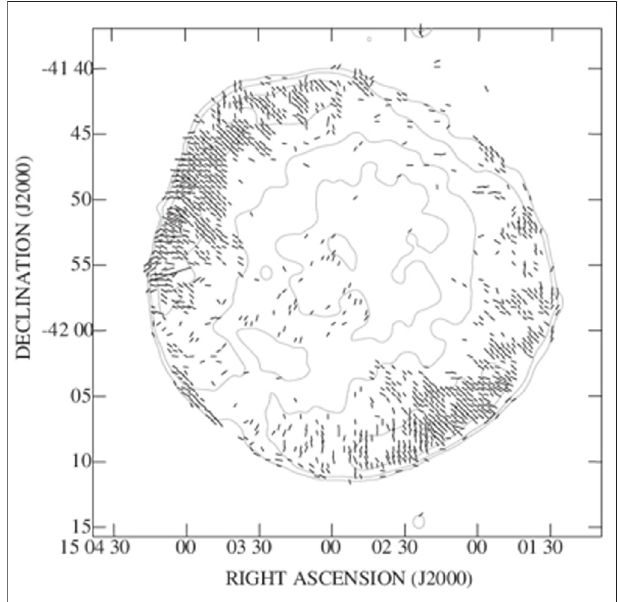
FIGURE2| Magnetic- fi eldorientationonSNRSN1006derivedfromthe radio polarimetry at 10 arcsec resolution (1.4 GHz). The polarization angle is corrected for Faraday rotation (assuming uniform rotation measure as 12 rad m − 2 ). Total intensity contours at 10, 20, and 50 mJy beam − 1 are superposed. For the bars, a length of 30 arcsec represents 0.25 mJy beam − 1 of polarized fl ux. This fi gure is taken from Reynoso et al. (2013, The Astronomical Journal, 145,4,104).